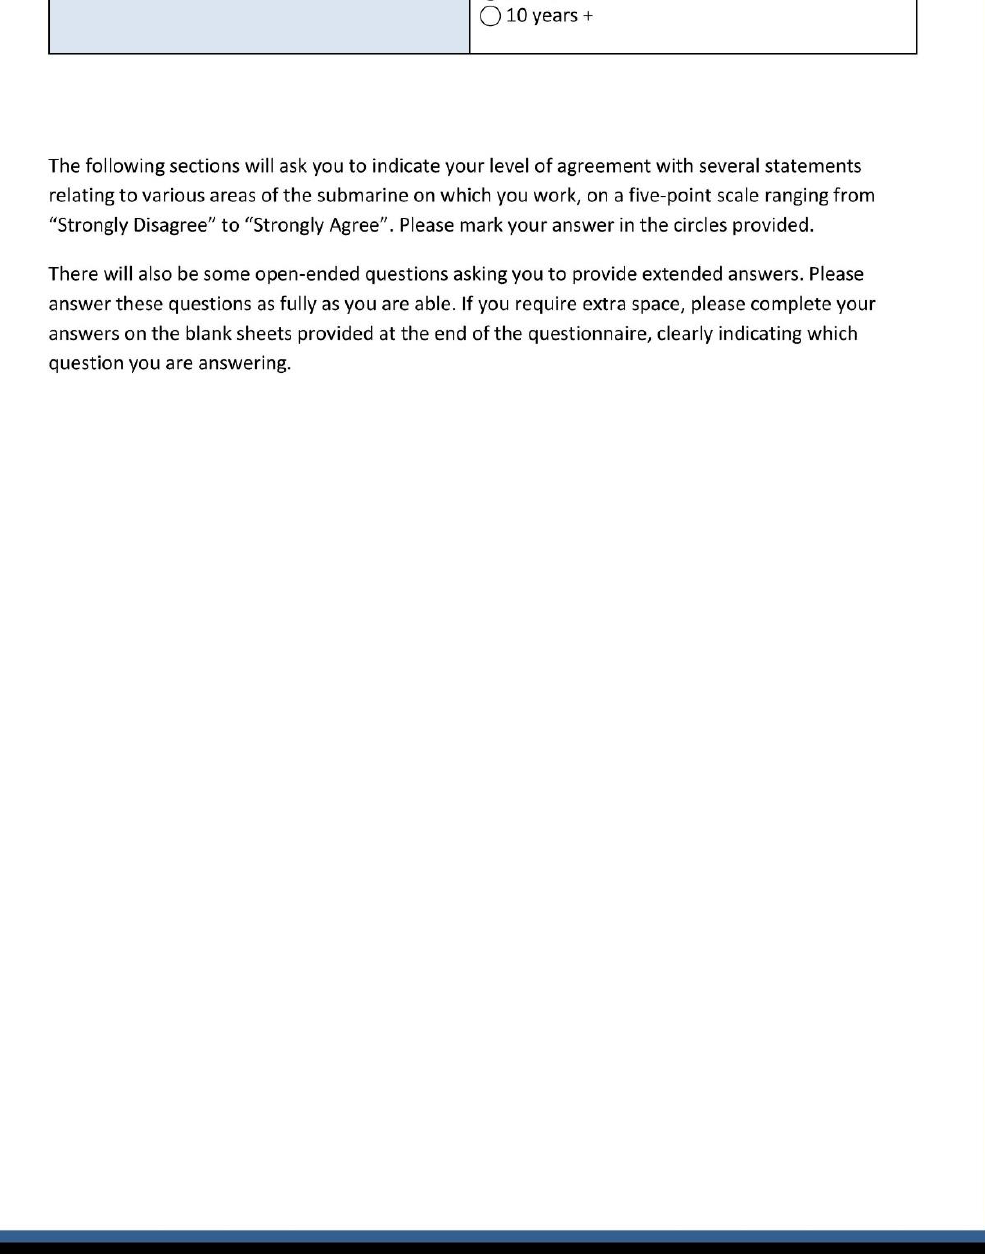
Figure A3. The Submarine Habitability Assessment Questionnaire (continued).